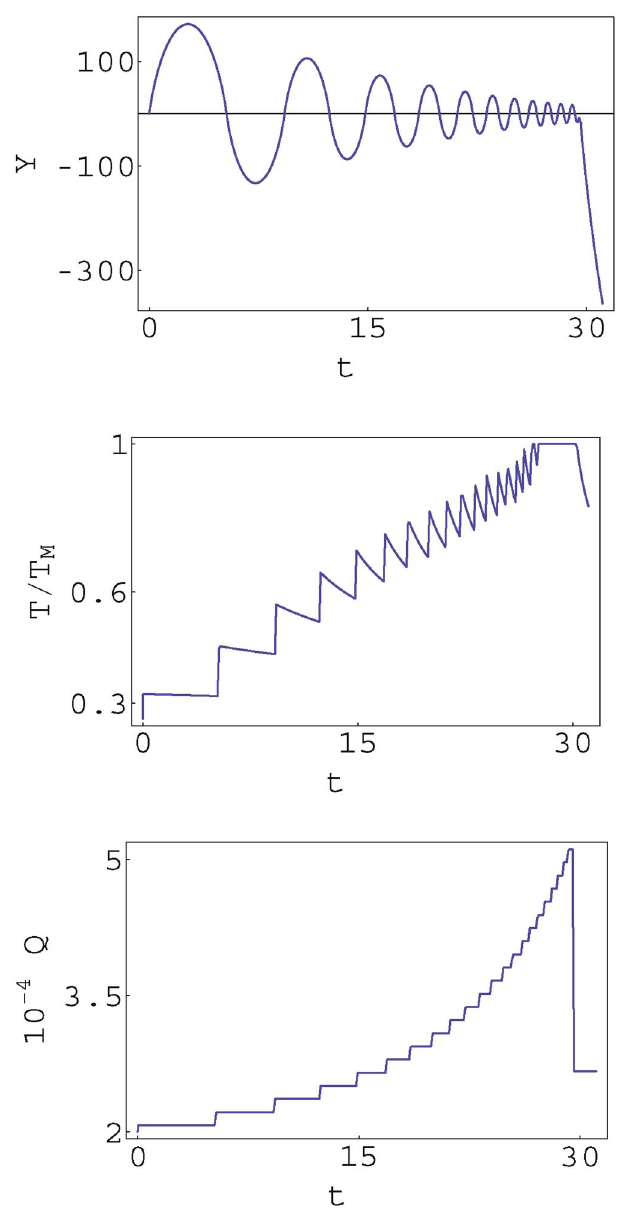
tracking.FIG. 5. (Color) 1D dynamics of a (cid:8) 0 : 2 (cid:3) m Ti dust particle for BEPC parameters. The lifetime of the dust particle is limited by fission due to the growing charge Q : when T exceeds the melting , the dust particle decays and the products hit the wall. point T M and time is in The vertical amplitude Y is in units of (cid:20) y